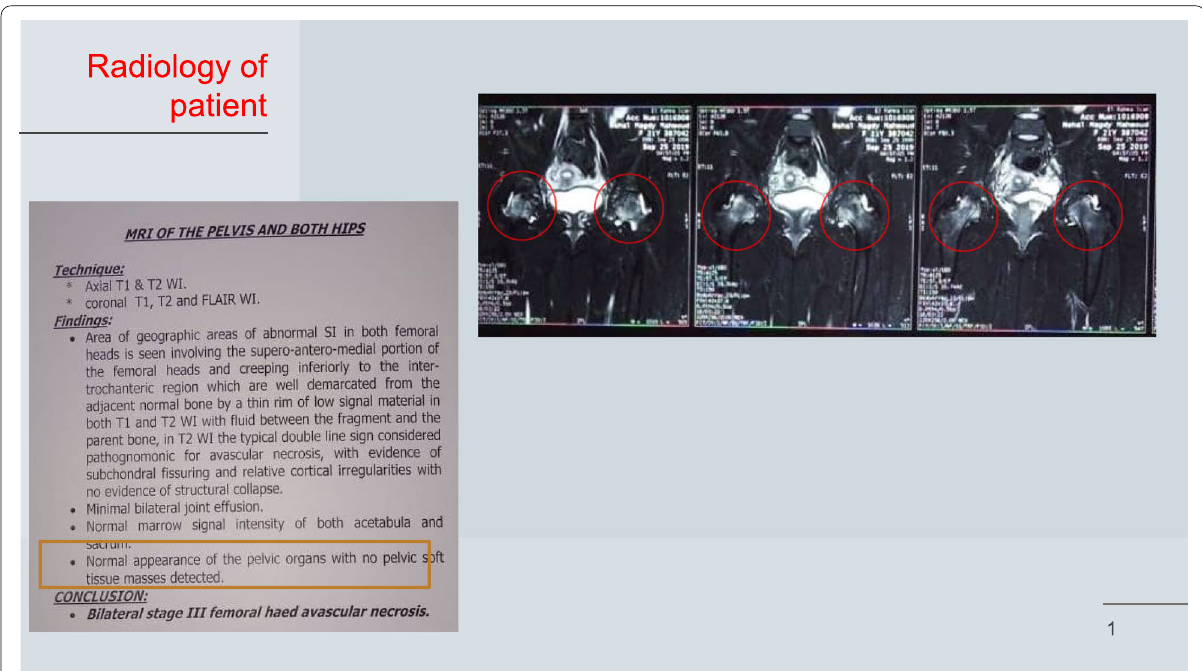
Fig. 1 MRI of both hips revealed abnormal signals in the superior-antero-medial portion of both femoral heads and inferiorly to the intertrochanteric region which are well demarcated from the adjacent normal bone by a thin rim of low signal material in both T1 and T2 WI with fluid between the fragment and the bone. T2 WI revealed the typical double line sign which is considered pathognomonic for avascular necrosis with evidence of subchondral fissuring and relative cortical irregularities with no evidence of structural collapse. Conclusion : bilateral stage III femoral head avascular